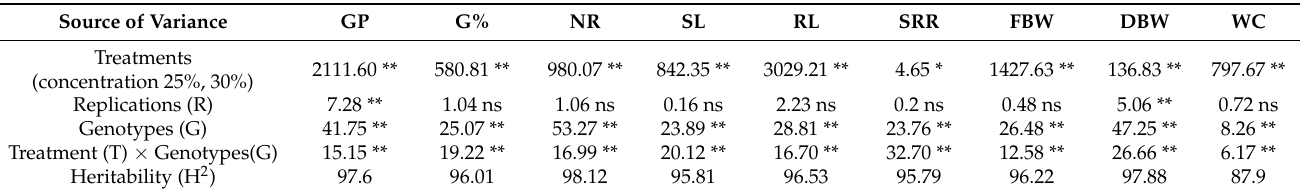
Table 2. Analysis of variance (ANOVA) for the seedling traits scored on 41 spring wheat genotypes under two PEG concentrations (25% and 30%).